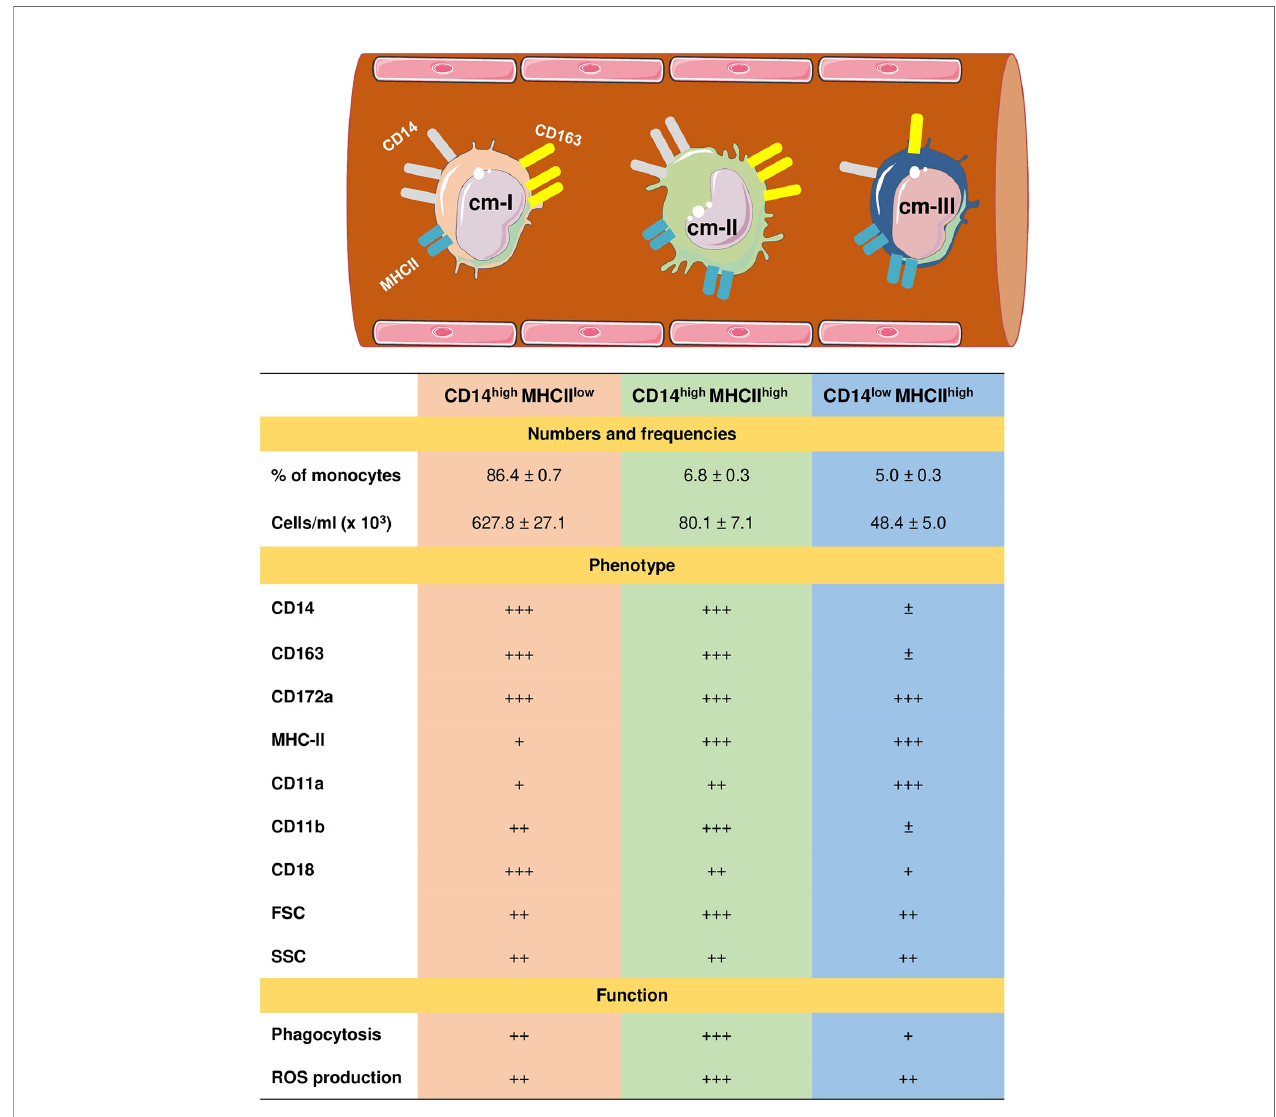
FIGURE 2 | Heterogeneity of camel monocyte subsets. Camel monocytes are subdivided according to the surface expression of CD14 and MHCII into three monocyte subsets. (1) Camel monocyte I (cM-I) with high expression of CD14 and low expression of MHCII (CD14 high MHCII low ), cM-II with high levels of both CD14 and MHCII (CD14 high MHCII high ) and cM-III with high expression of MHCII but low expression of CD14 (CD14 low MHCII high ). The expression levels of cell surface molecules are presented as ± for very low to no-expression, + for weak expression, ++ for intermediate expression, and +++ for high expression. Functional capacities of monocyte subsets are presented as + for weak, ++ for intermediate, and +++ for strong